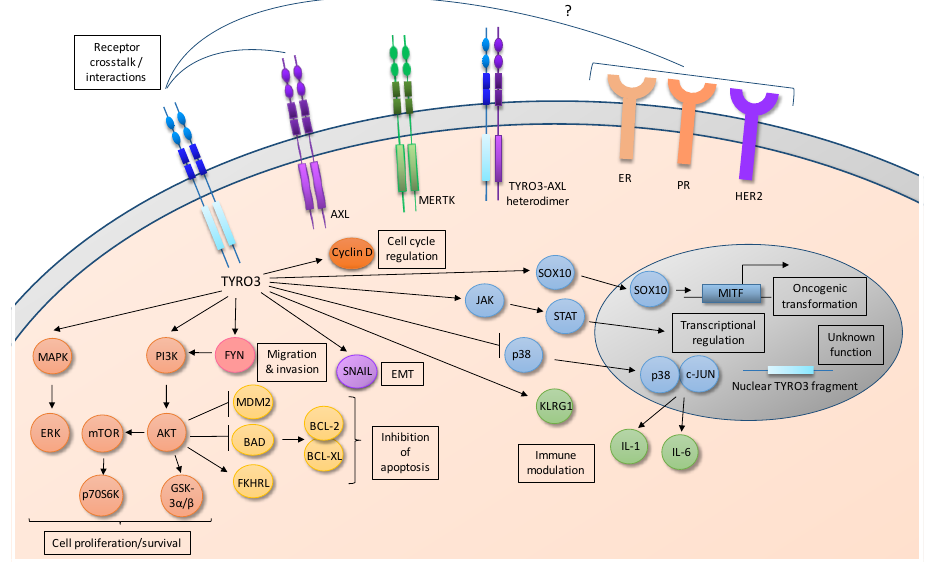
Figure 2: TYRO3 Cell Signaling. TYRO3 regulates pathways important for cell proliferation and survival, (e.g., PI3K/AKT/mTOR and MAPK/ERK signaling), migration and invasion, epithelial-to- mesenchymal transition (EMT), cell cycle regulation, transcriptional regulation, immune modulation and oncogenic transformation. TYRO3 and AXL heterodimerization has been reported, although their functional significance is unknown, and crosstalk between TYRO3 and estrogen receptors (ER), progesterone receptors (PR) and/or HER2 receptors has been implicated in breast cancer cells. The function of nuclear TYRO3 is